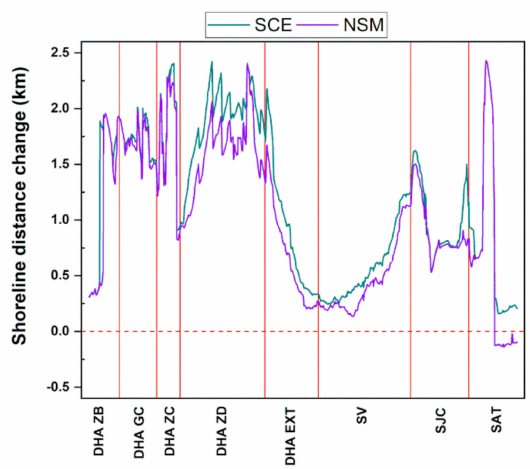
Figure 6. Shoreline change (NSM, SCE) of eastern change (DHA = Defense housing Authority; ZB = Zone B; GC = Golf Club; ZC = Zone C; Ext = Extension, SV = Sea-view, SJC = Shireen Jinnah Colony, SAT = South Asian